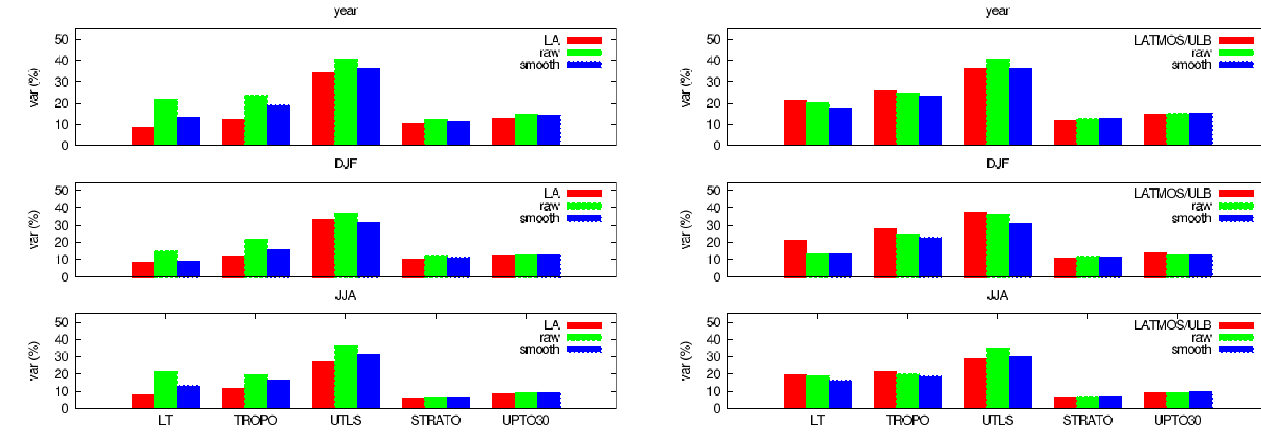
Fig. 6. Standard deviation (%) of the mean partial columns of ozone averaged over the set of pixels defined for the validation in the case of the LA product over the entire year 2008 (top panel), over winter (middle panel), and over summer (bottom panel). The standard de- viation is given for the retrieved columns, the measured ozonesonde columns and the smoothed ozonesonde columns. It represents the variability of ozone. The definition of the partial columns is given in Sect. 3.